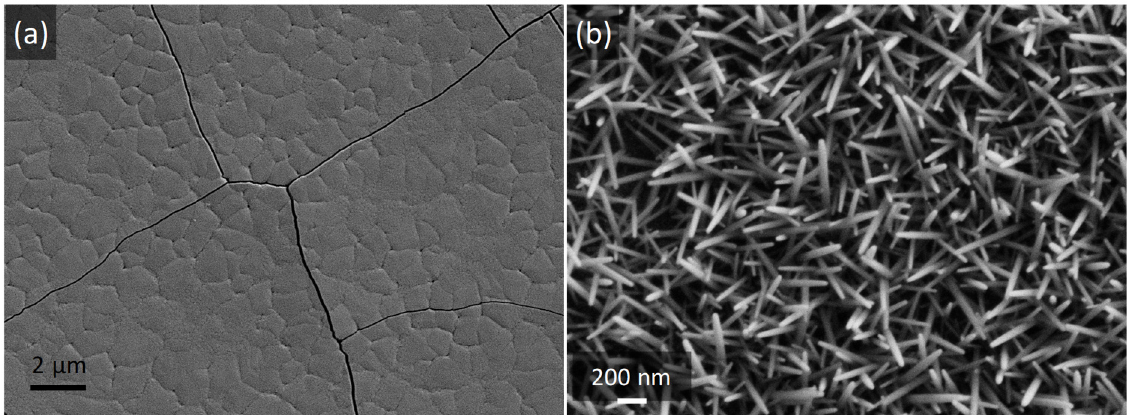
Figure 2. SEM images of ( a) YAG:Ce coating alone and ( b ) ZnO nanowires grown from a ZnO seed layer deposited on a bare silica substrate.